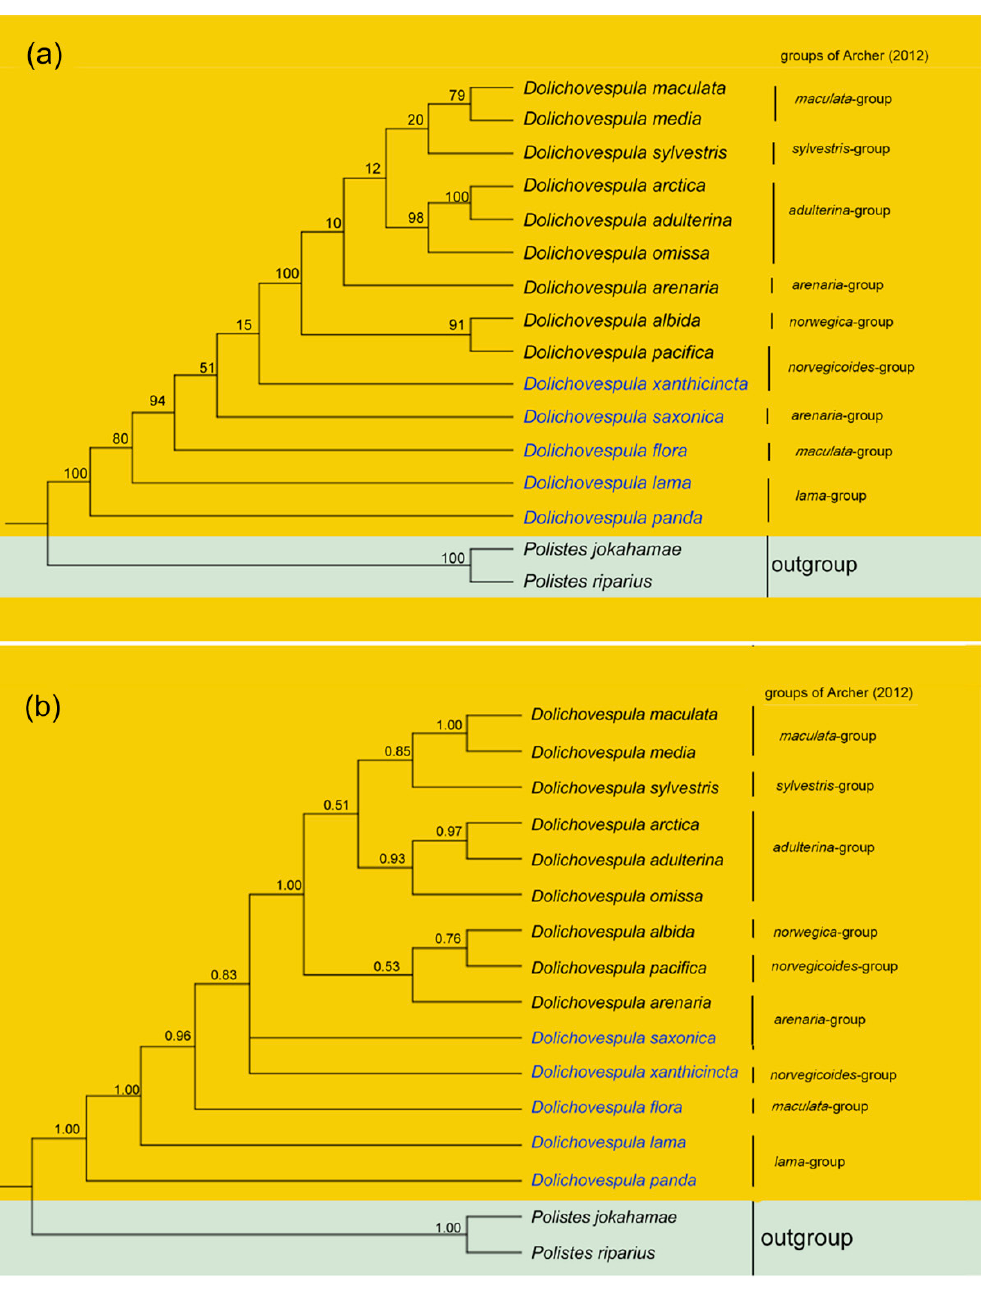
Figure 5. Phylogenetic trees based on five mitochondrial genes ( cob , cox1 , cox2 , rrnL and rrnS ) of 14 species of Dolichovespula with two Polistes sp. as the outgroup. The species groups of Archer (2012) were noted. ( a ) under Maximum Likelihood (ML); ( b ) under Bayesian inference (BI). Values above the nodes represent bootstrap values ( a ) or Bayesian posterior probabilities ( b ).